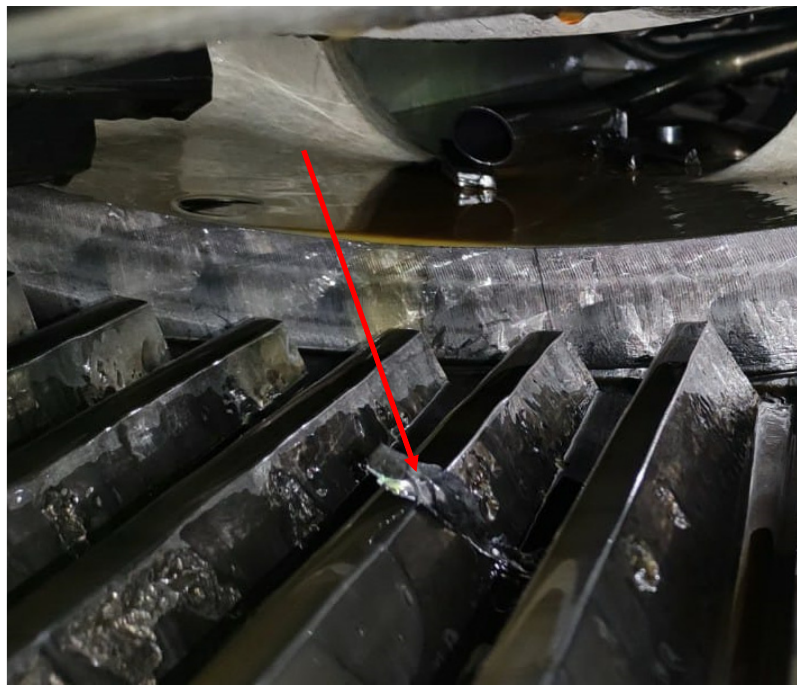
Figure 9. Breaking off material particles from the surface layer (arrow). Energies 2021 , 14 , 6768